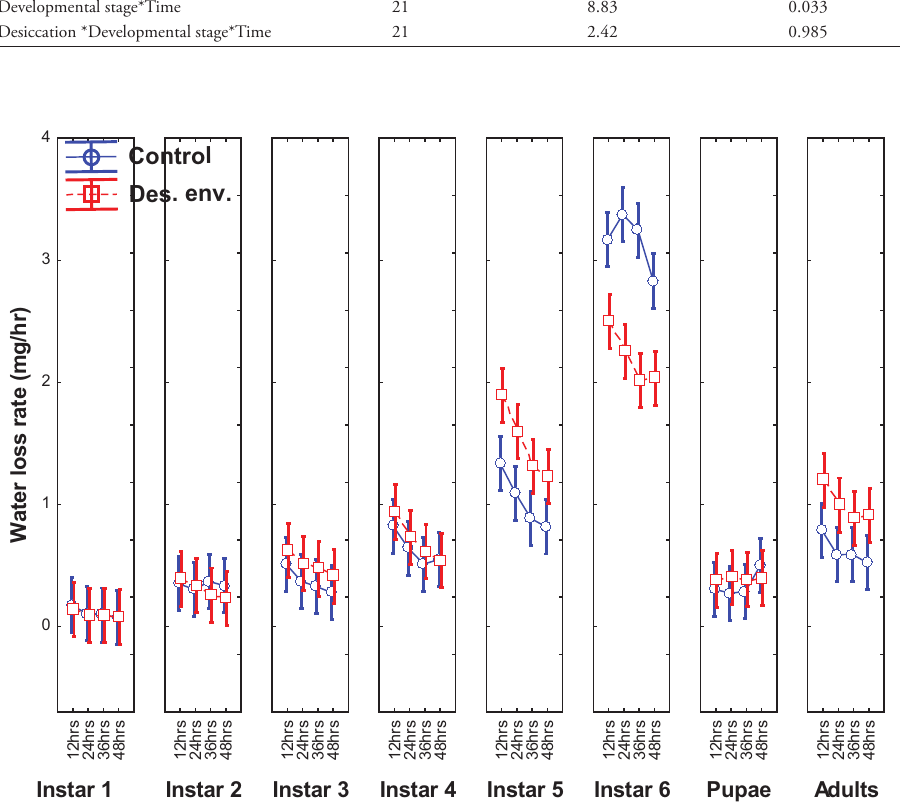
Figure 2. Water loss rates of S. frugiperda larvae (instars 1–6), pupae and adults following 12, 24, 36 and 48 h desiccation exposure at 7% RH. Error bars represent 95% confidence limits (N = 20 per treatment group). Des. env. = desiccation treatment (7%